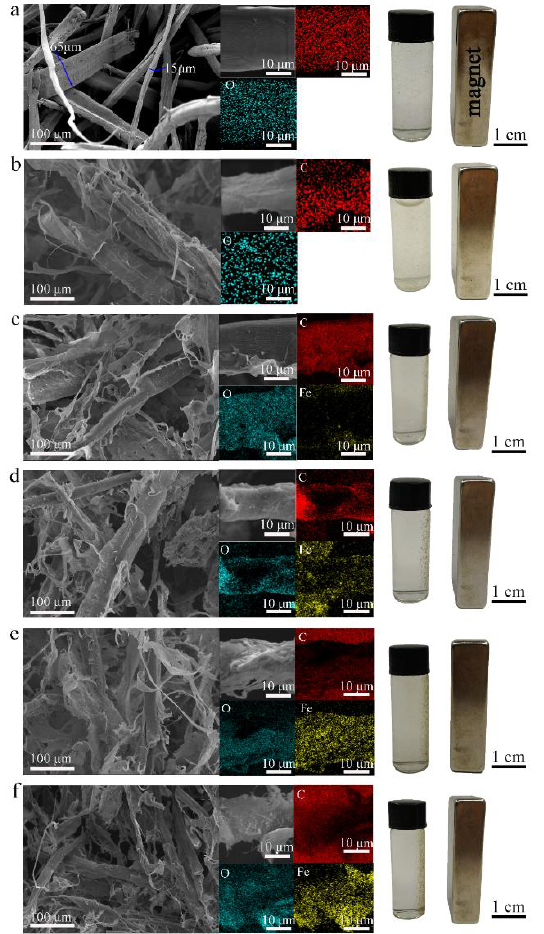
Figure 1. Digital images and scanning electron microscopy (SEM)/energy dispersive X-ray spectroscopy (EDS) mapping images of fiber ( a ); treated fiber ( b ) and nano-Fe 3 O 4 /Fiber (NFF) composite with different contents of Fe 3 O 4 NPs. (( c ) NFF1; ( d ) NFF2; ( e ) NFF3; ( f ) NFF4).